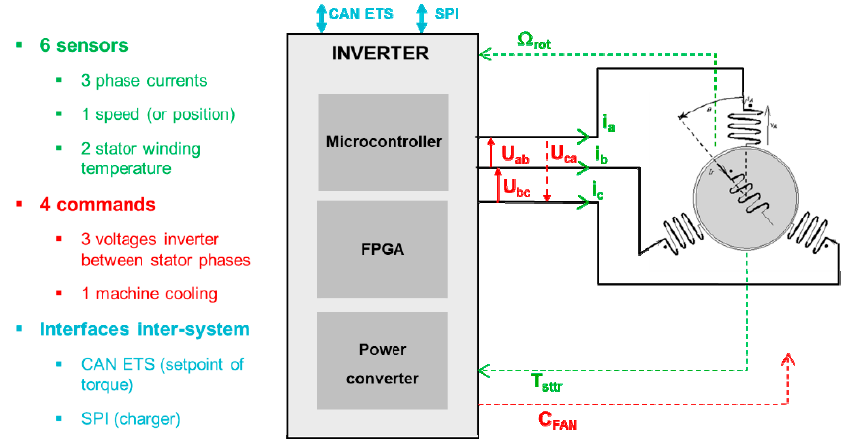
Figure 2. Synoptic of the control interfaces.